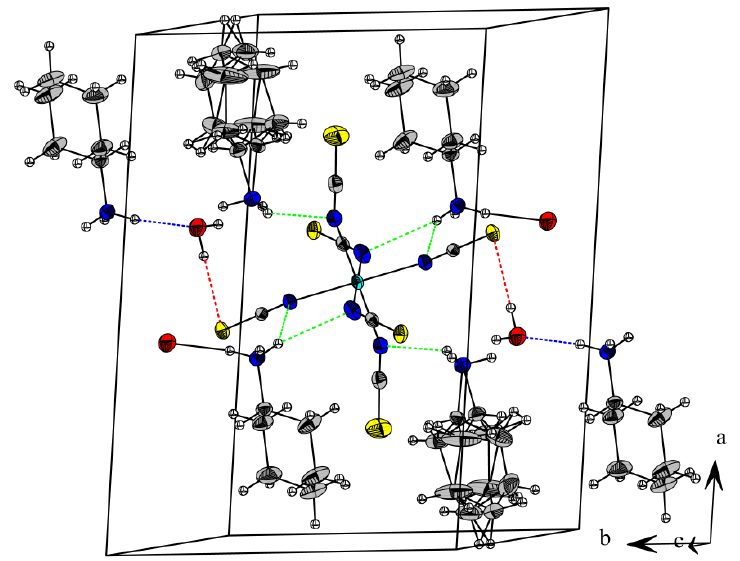
Figure 5. Hydrogen bonds in (C 6 H 11 NH 3 ) 4 [Ni(NCS) 6 ] · 2H 2 O at 120 K. The blue, green, and red dashed lines correspond to N—H · · · O, N—H · · · N, and O—H · · · S hydrogen bonds, respectively.